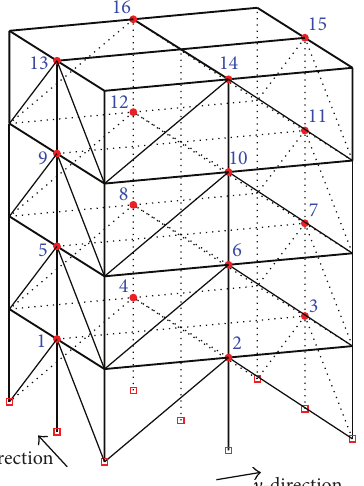
Figure 4: The sketch of the analytical model and the sensor locations. Figure 5: Original signal and first four approximate modal responses at point